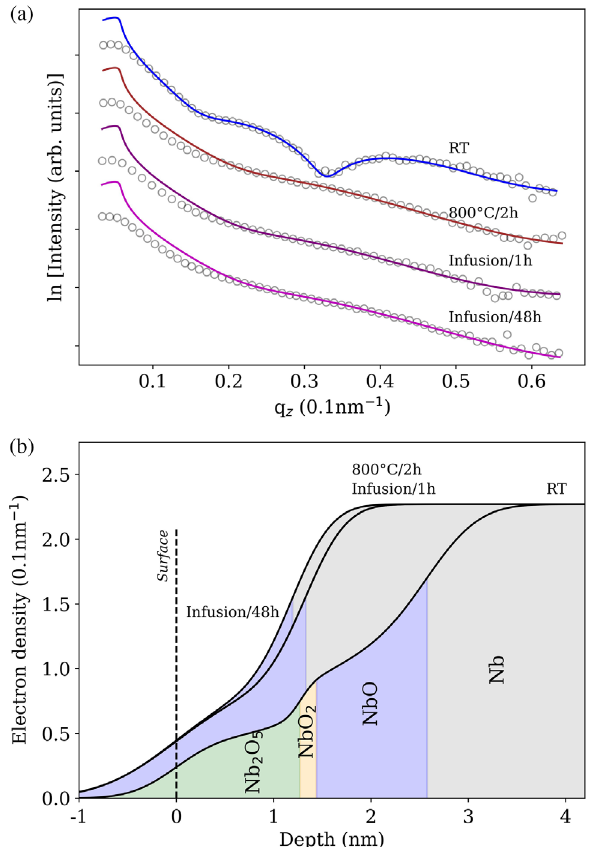
FIG. 3. (a) X-ray reflectivity data measured with CuK α radi- ation (open circles) with respective fits (solid lines) for various steps of the infusion procedure. The sample curvature com- promises the fit in the first few data points. The scans are offset in the y direction for better visibility. (b) Electron density profiles for each step. The extracted densities are lower than the expected bulk values for the niobium oxides and metallic niobium due to the pronounced sample